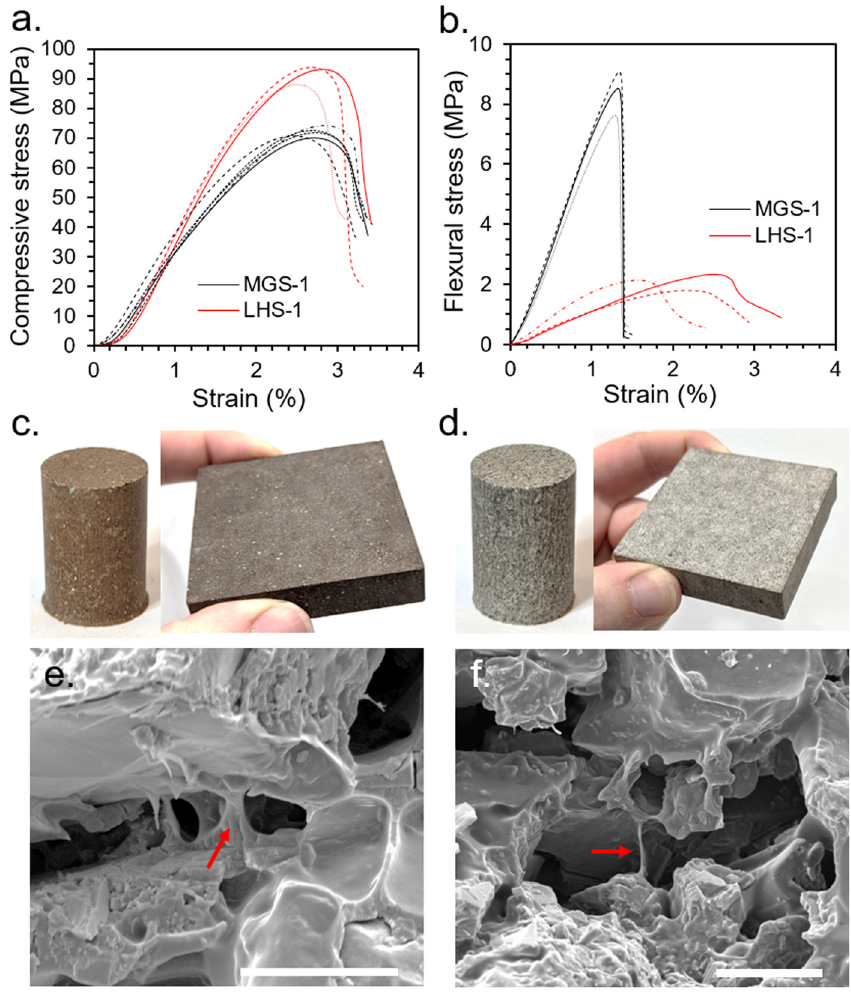
Figure 3: Stress – strain pro fi les for Martian ( MGS - 1 ) and lunar ( LHS - 1 ) Starcrete undergoing ( a ) uniaxial compression tests and ( b ) three - point fl exural tests. ( c ) and ( d ) Camera images Martian and lunar Starcrete, respectively. ( e ) and ( f ) SEM images of Martian and lunar Starcrete, respectively. Scale bars = 20